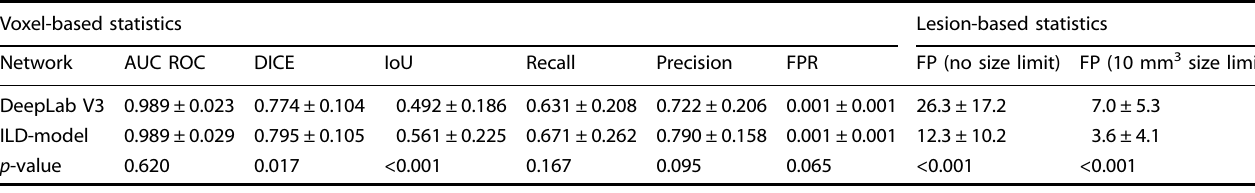
Table 1. Detection accuracy and segmentation performance.